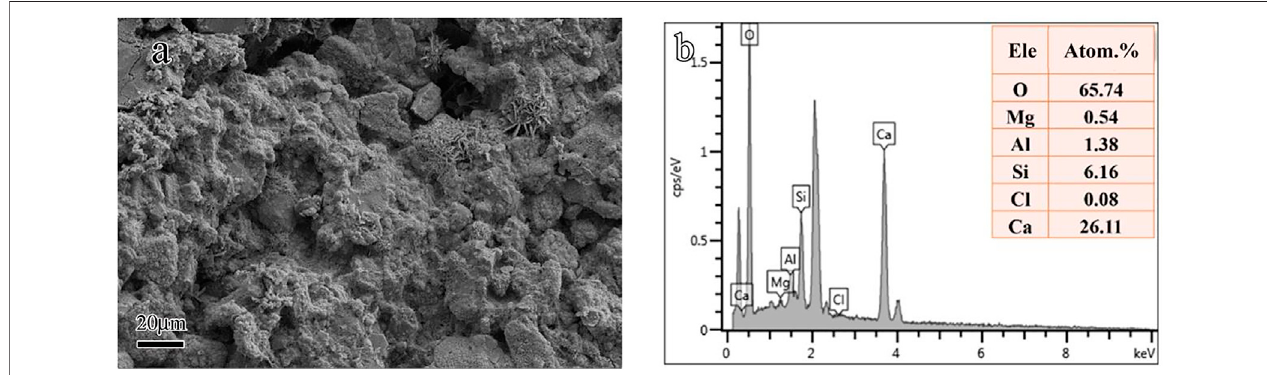
FIGURE 12 | Low and high magni fi cation SEM morphologies of cement paste in concrete modi fi ed with nano Al 2 O 3 before F/T and W/D cycles. (A) Low magni fi cation image, (B) High magni fi cation image, and (C) EDS results corresponding to (B) .